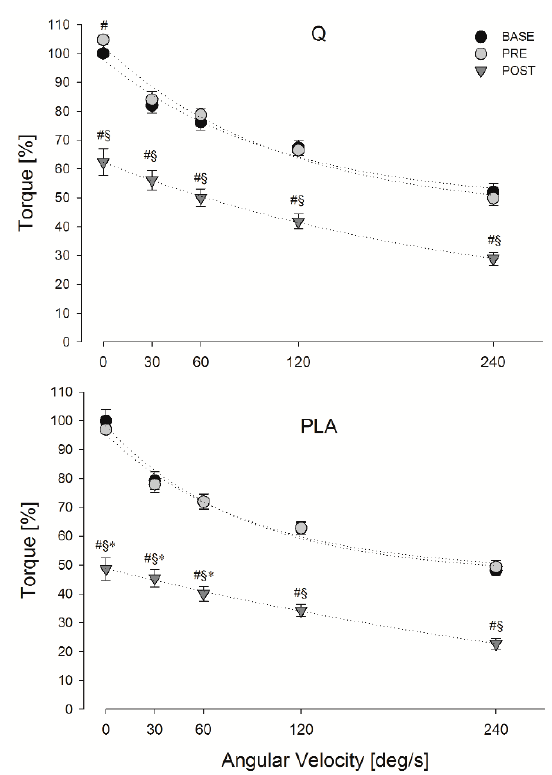
Figure 4. Mean torque values obtained during the FV relationship task in Q (panel A) and PLA (panel